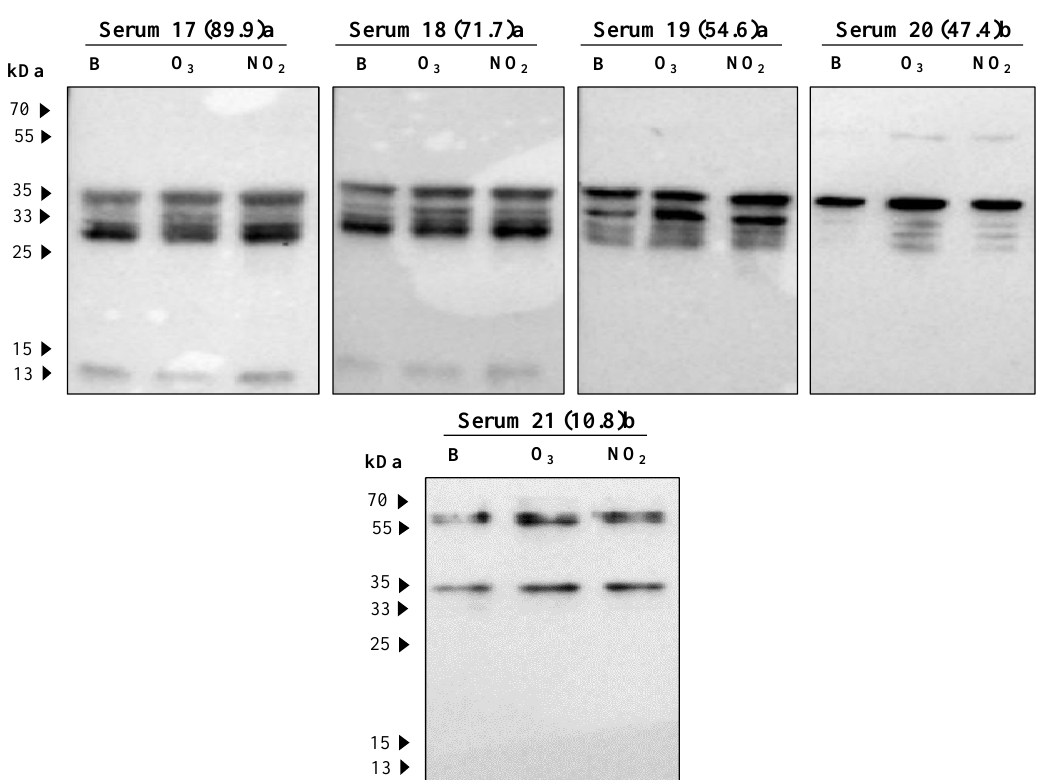
Figure 5. Immunoblot results from 21 sera of patients sensitised to grass pollen showing the IgE- reactive bands against protein extracts of Dactylis glomerata pollen non-exposed (B) and exposed to pollutants (O 3 or NO 2 ). At the top of each immunoblot in brackets is the serum IgE concentration (kUA/L), and the letter corresponding to the sensitisation (a: gx1 — Poaceae mixture of Dactylis glomerata, Festuca elatior , Lolium perenne , Phleum pratense , and Poa pratensis ; b: g3 — Dactylis glomerata ).